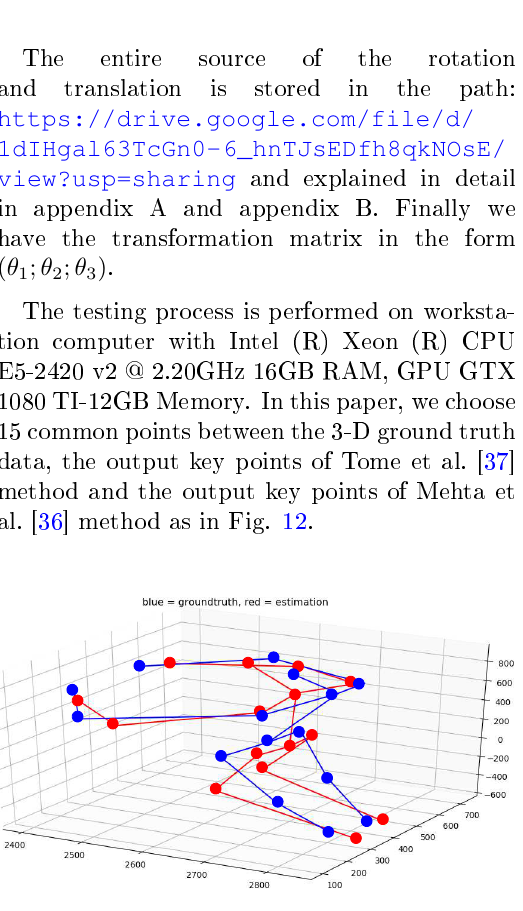
Fig. 12: Illustrating 3-D human pose for evaluating 3-D human pose estimation. The blue key points are ground truth data, the red key points are the estimated data which transformed the same coordinate